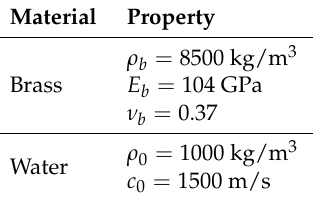
Figure 6. Experimental measurements are represented using black squares, whereas the simulated results are depicted as solid lines in both longitudinal (blue) and transversal (red)